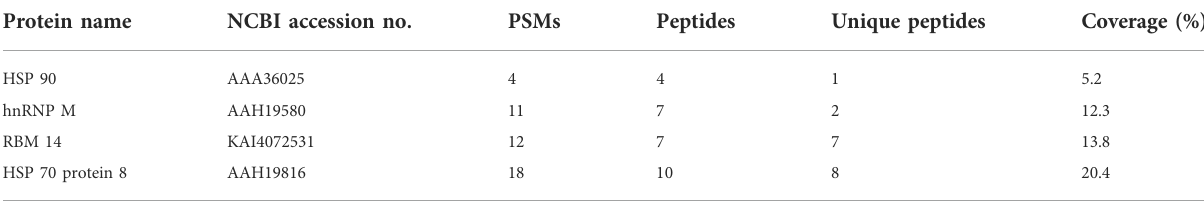
TABLE 2 Candidate proteins with DNA binding ability. Numbers of peptide spectrum matches (PSMs), peptides, and unique peptides not present in other proteins, and percentages of coverage are shown. Protein